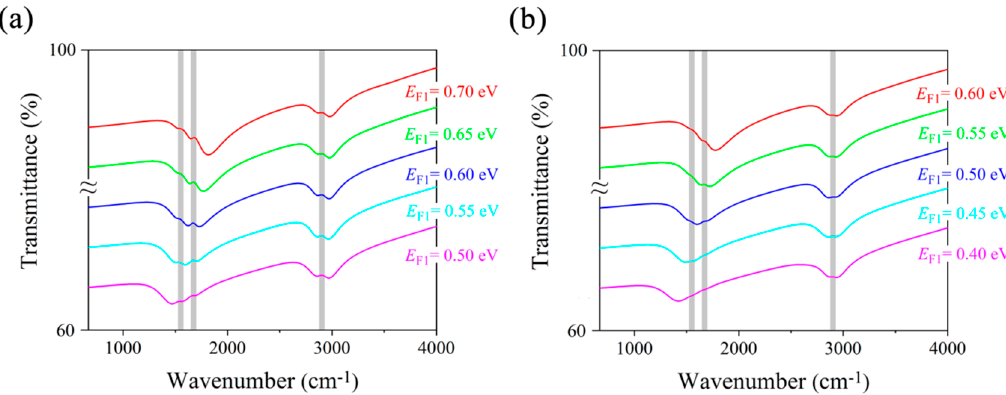
Figure 5. Transmittance spectra of MRGB with different E F 1 while accessing different thicknesses of biomolecular layer. ( a ) For biomolecular layer of 8 nm, E F 2 = 0.85 eV. ( b ) For biomolecular layer of 2 nm, E F 2 = 0.75 eV. Other parameters are the same as in Figure 2. Curve with larger E F is translated upward with 6% in order to demonstrate the spectral shift clearly.